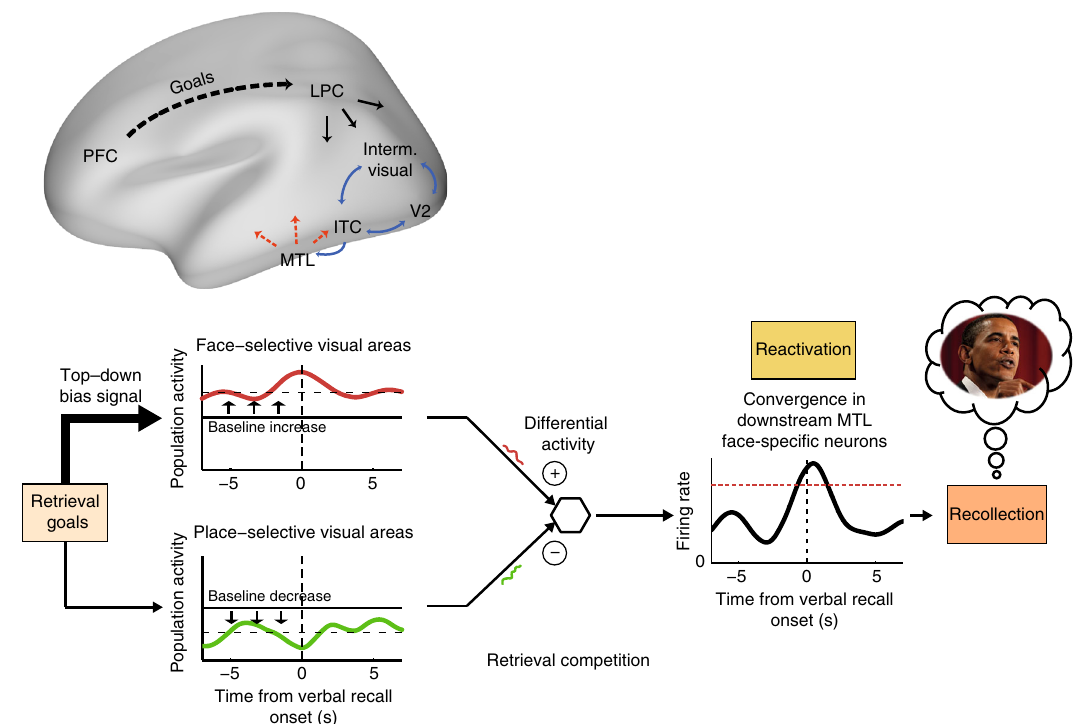
Fig. 10 Proposed model for top − down control during free recall: targeting face-related memories. Top − down control signals are thought to originate in the prefrontal cortex and to be projected to visual areas through fronto-parietal networks. Such signals modulate the baseline activity in content-speci fi c visual areas in accordance with retrieval goals, thereby biasing the retrieval competition towards speci fi c memories. Stochastic fl uctuations in neuronal activity within such maintained “ attentional set ” may occasionally reactivate the desired mnemonic representations in downstream neurons, where visual inputs converge. The overall differential activity between face-selective neural ensembles and other category-selective populations facilitates the reactivation of downstream MTL neurons, which in turn evoke the relevant recall event. An awareness threshold (red dashed line) is hypothesized to account for the long (1 – 2 s) delay between the onset of MTL activation and the verbal report. Abbreviations: MTL — medial temporal lobe, ITC — inferior temporal cortex, LPC